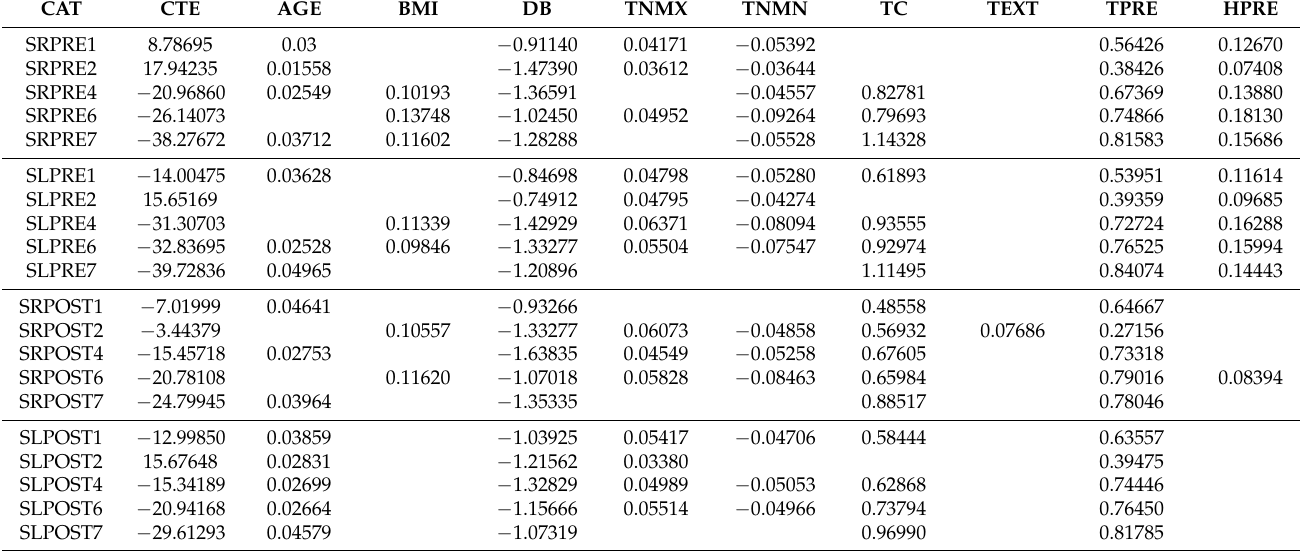
Table 1. Coefficients that have been obtained with the model. SRPREi represents the temperature for right (R) sole (S) before (PRE) the walk for index i, SLPOSTi represents the temperature for left (L) sole (S) after (POST) the walk for index i, and SRPOSTi represents the temperature for right sole after the walk for index i. Where I can be 1, 2, 4, 6 and 7 indicating the region where the index is